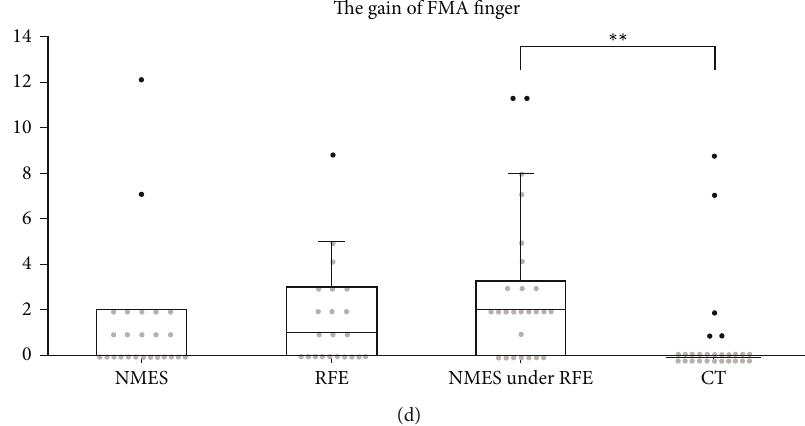
Figure 3: FMA item gain comparison of each group. FMA: Fugl-Meyer Assessment; NMES: neuromuscular electrical stimulation; RFE: repetitive facilitative exercise; CT: conventional training. (a) FMA upper limb total score, (b) FMA shoulder and elbow score, (c) FMA wrist score, (d) FMA fi nger score. Scatter plot (circles: individual patients) and box-and-whisker plot (minimum, quartiles, and maximum) of FMA gain in each group, Black circle: outliers over 1 : 5 × interquartilerange . Signi fi cant di ff erences were observed in the upper limb total score, wrist, and fi nger FMA scores between CT and NMES under RFE ( ∗ p < 0 : 05 , ∗∗ p < 0 : 01